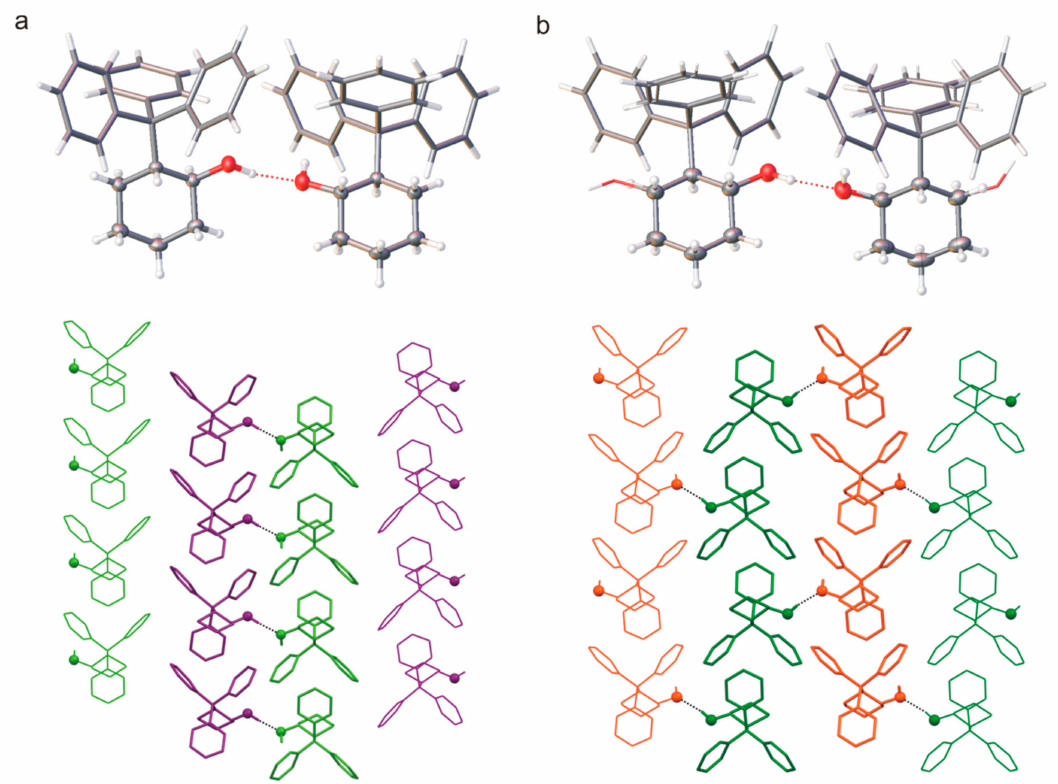
Figure 4. The molecular structure of asymmetric unit and supramolecular column in crystal structure of compound rac - 3 : ( a ) polymorph α ,( b ) polymorph β . The oxygen atoms are presented as balls and hydrogen bonds are shown as dashed